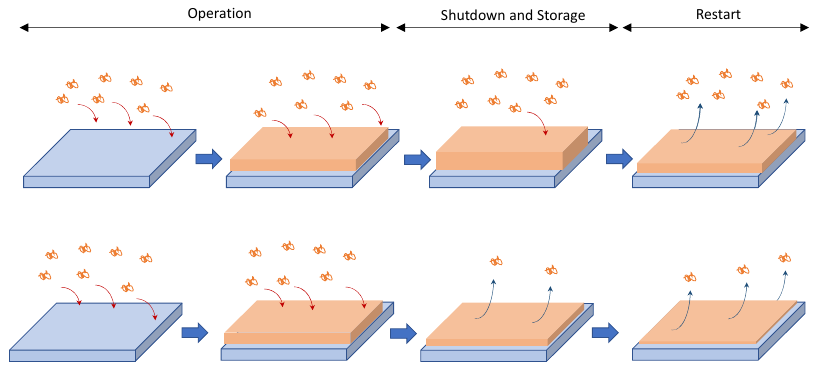
Figure 9. Changes in the foulant layer thickness in the intermi tt ent operating cycle. ( a ) RO operation with membrane storage in the feed water (Case 2). ( b ) RO operation with the membrane storage in DI water (Case 3).